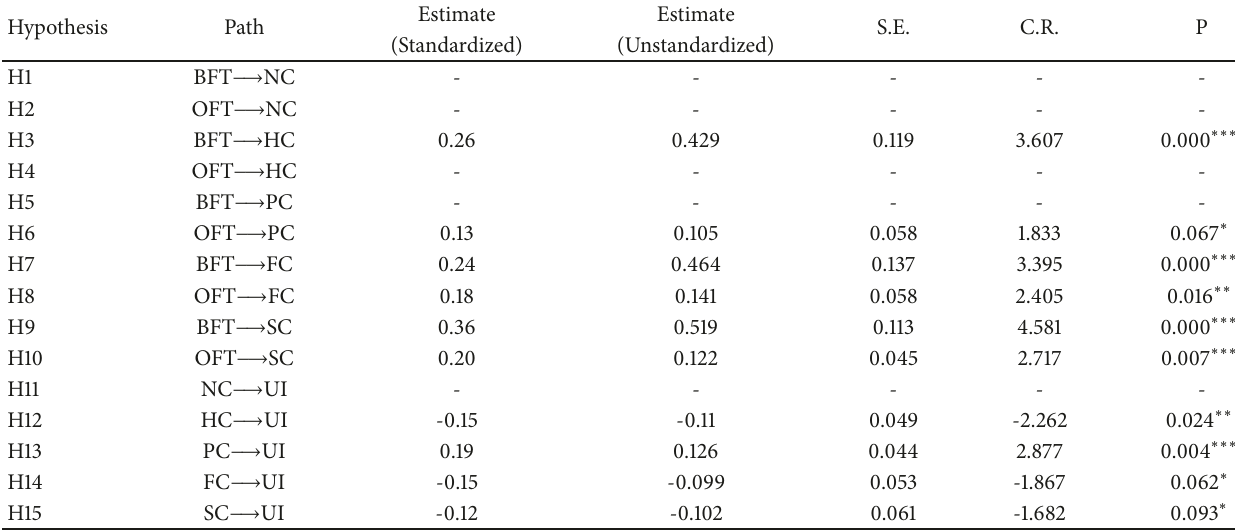
Table 6: Parameter